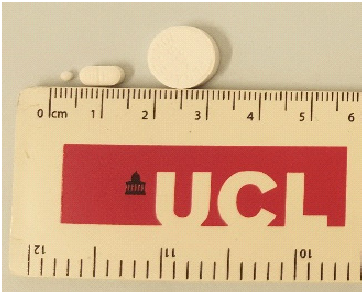
Figure 1. Size of a typical mini-tablet (left) compared to conventional tablets .